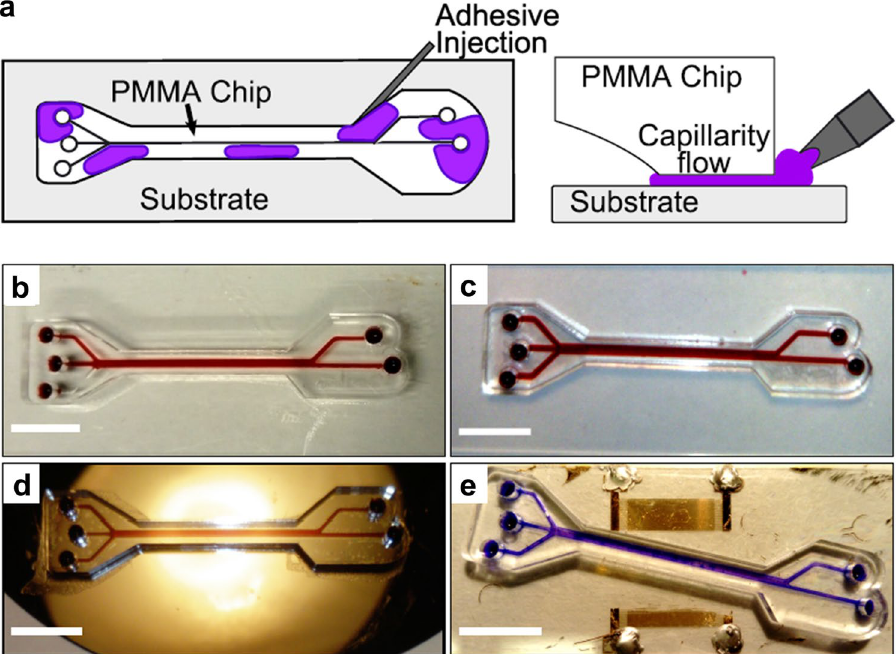
Figure 5. Capillarity-assisted adhesive bonding. ( a ) Schematic of the adhesive delivery method. The adhesive mix is injected into the interstitial space between the chip and the substrate, and capillarity forces drive the flow of the adhesive throughout the bonding surfaces without flooding the channels. ( b – e ) PMMA microfluidic devices adhesively-bonded via capillarity-assisted adhesive delivery on PMMA ( b ) glass ( c ) silicon ( d ) and LiNbO 3 ( e ) substrates. Scale bar: 1